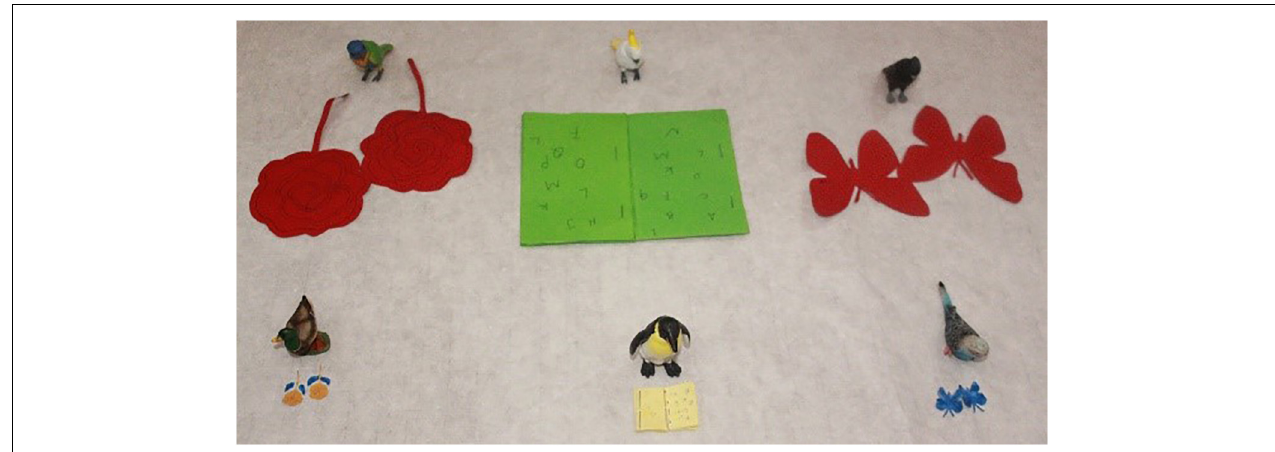
FIGURE 3 | Last scene of the story (individual-oriented